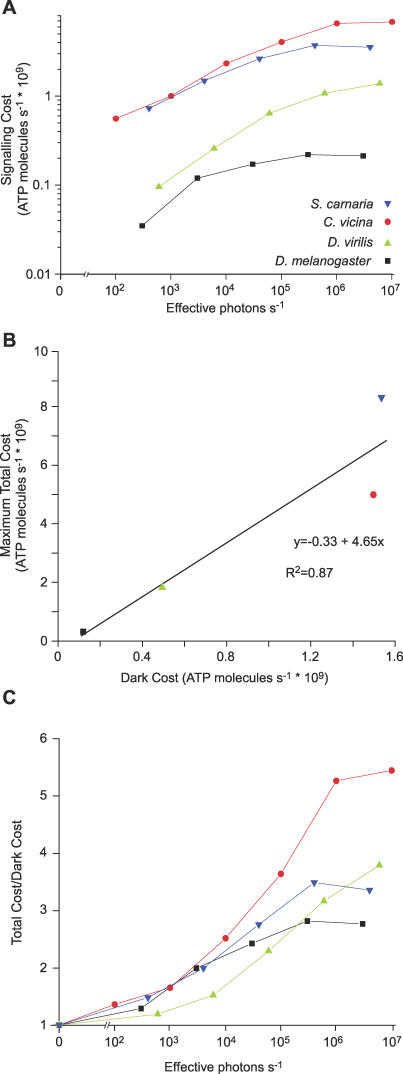
The Relationship between the Signalling Cost and the Fixed (Dark) Cost for R1–6 Photoreceptors from the Four Species S. carnaria, C. vicina, D.virilis, and D. melanogaster
(A) The rate of hydrolysis of ATP molecules during signalling at each effective photon rate.(B) The maximum signalling cost versus the fixed cost for each of the four R1–6 photoreceptor types. The maximum is the signalling cost measured at the brightest light levels.(C) The ratio of total cost to fixed cost of each photoreceptor type at each effective photon rate.